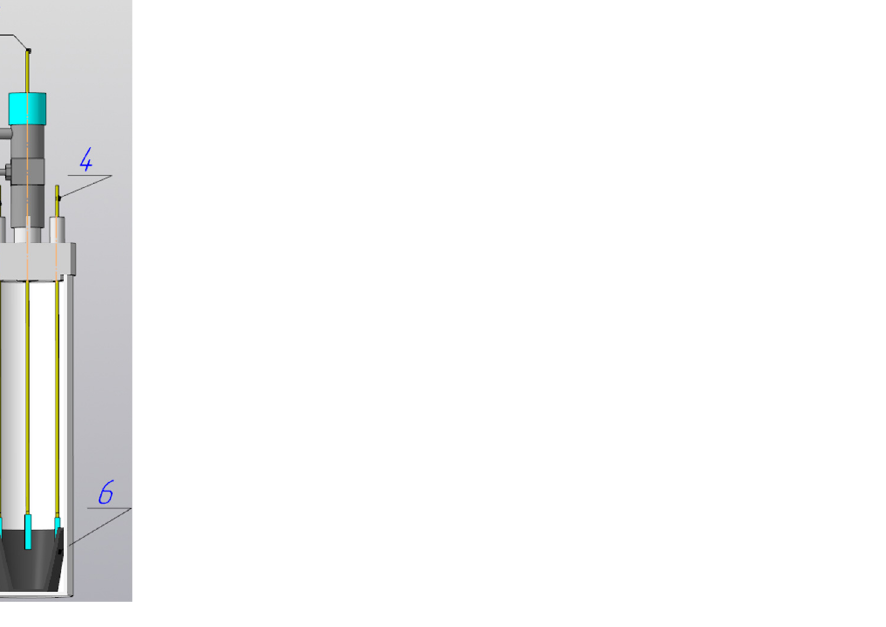
Figure 1. Experimental setup. 1—working electrode; 2—gas inlet; 3—quartz cell; 4 —counter electrode; 5—quasi-reference electrodes; 6—glassy carbon